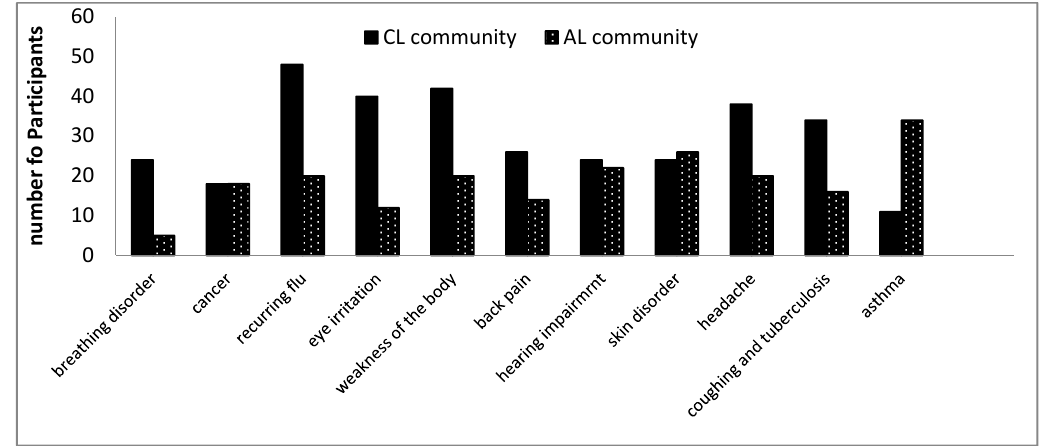
Figure 10. C omparison between both communities showing how frequent the illnesses impact them. Figure 10. Comparison between both communities showing how frequent the illnesses impact